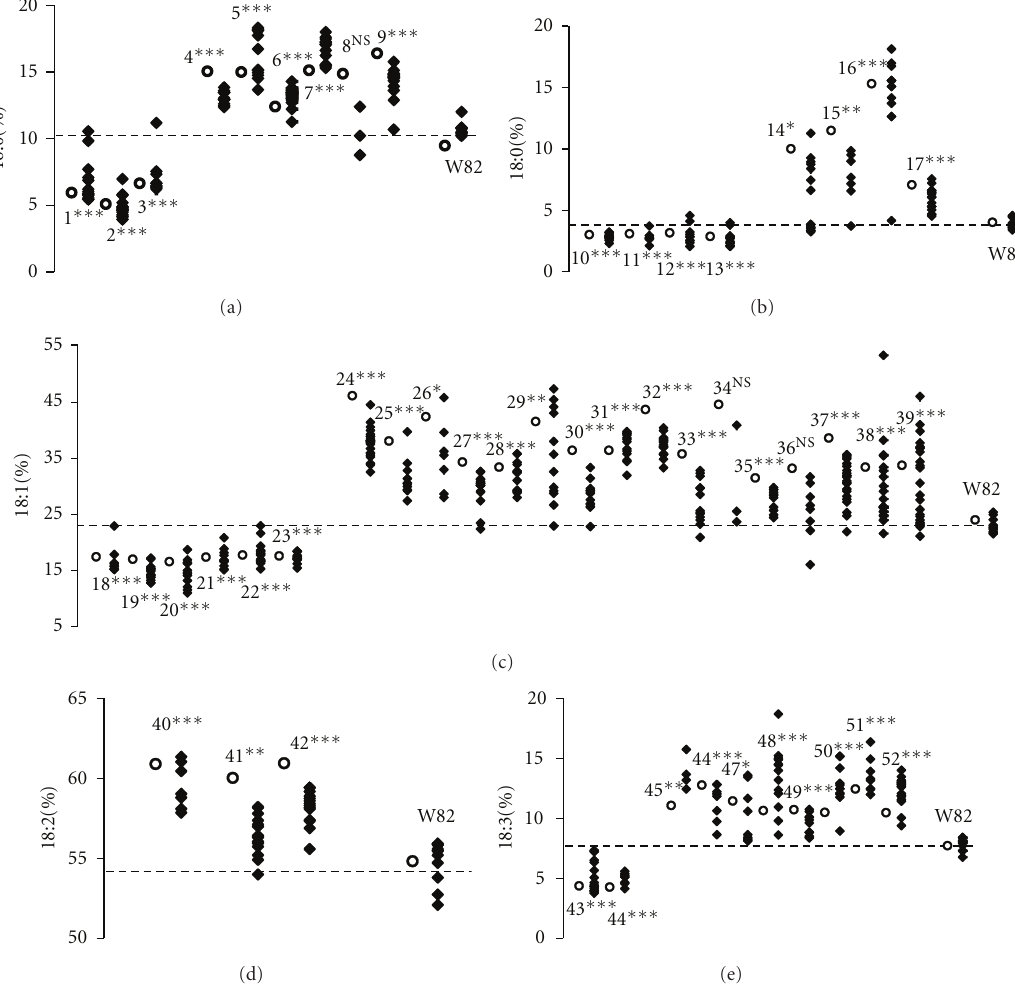
Figure 2: Reproducibility for fatty acid levels in selected mutant lines. For each M 3 -M 4 pair the open circle on the left represents the fatty acid level observed in the M 3 seeds, and the black diamonds represent the levels observed in the M 4 seeds descended from M 3 individuals. Key for the labeling of each line is found in Table 1. The dotted horizontal bars on each plot represent the mean level of the fatty acid in wild-type Williams-82 (W82) seed samples. Actual values for a representative W82 sample (as well as values for single plant progeny from this W82 plant) is plotted on the far right of each plot for reference. Level of significance was calculated by Welch’s t -test comparing values from M 4 samples to these ten wild type seed samples. ∗ P < 0 . 05, ∗∗ P < 0 . 01, ∗∗∗ P < 0 . 001, NS: not significant. (a) Palmitic acid mutants (mean palmitic acid for W82 = 10.6%), (b) stearic acid mutants (mean stearic acid for W82 = 3.9%), (c) oleic acid mutants (mean oleic acid for W82 = 23.2%), (d) linoleic acid mutants (mean linoleic acid for W82 = 54.8%), and (e) linolenic acid mutants (mean linolenic acid for W82 =